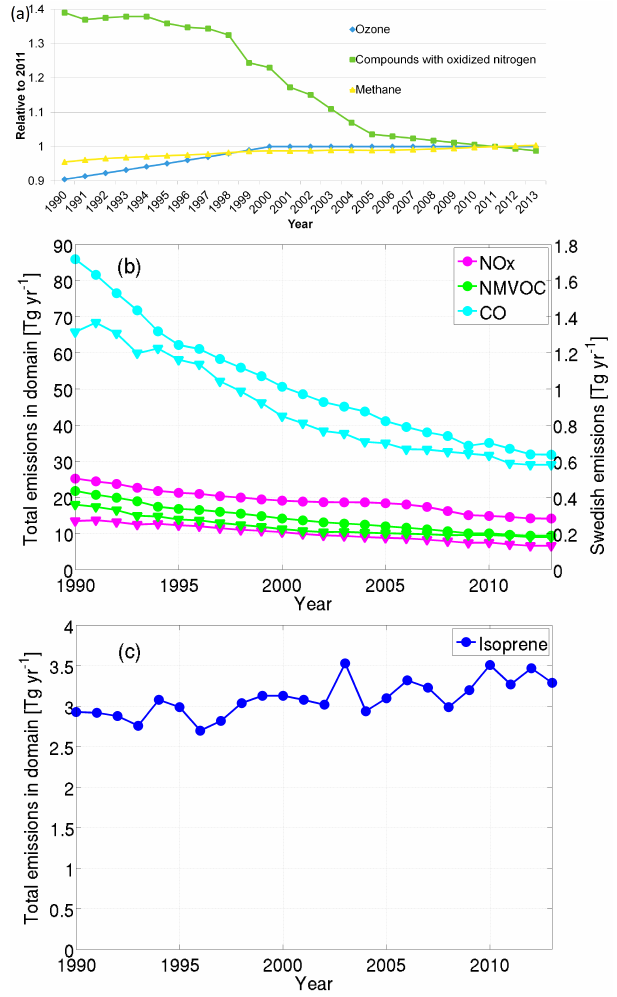
Figure 2. (a) Temporal trend of factors used for scaling boundary concentration of relevant species (based on Engardt et al., 2017). (b) Temporal trend of total domain (circles; left vertical scale) and Swedish (triangles; right vertical scale) annual anthropogenic O 3 precursor emissions utilized by MATCH from 1990 to 2013. Emis- sions of nitrogen oxides (NO x ), non-methane volatile organic com- pounds (NMVOC) and carbon monoxide (CO) are indicated by dif- ferent colors (cf. legend); emissions of sulfur oxides (SO x ) and am- monia (NH 3 ) are excluded from the panel. (c) Temporal trend of total domain biogenic isoprene